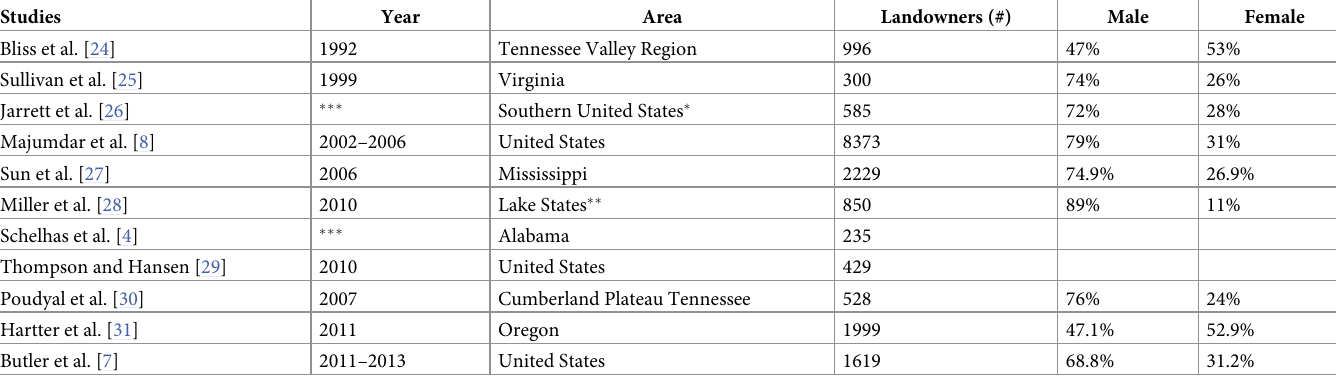
Table 1. Summary of the existing literature pertaining to female forest